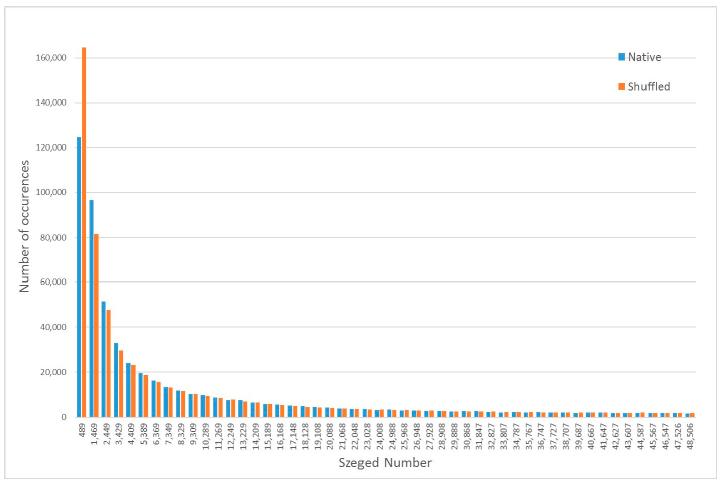
Figure 3. A histogram of the first 50 bins corresponding to the lowest Szeged numbers of all RNA structures in our dataset (with the exception of multi-branch loops), which are native sequences, compared to their shuffled sequences obtained using shuffleseq from EMBOSS. Reported p -value (see text) is less than 0.0001. Mathematics 2021 , 9 , x FOR PEER REVIEW